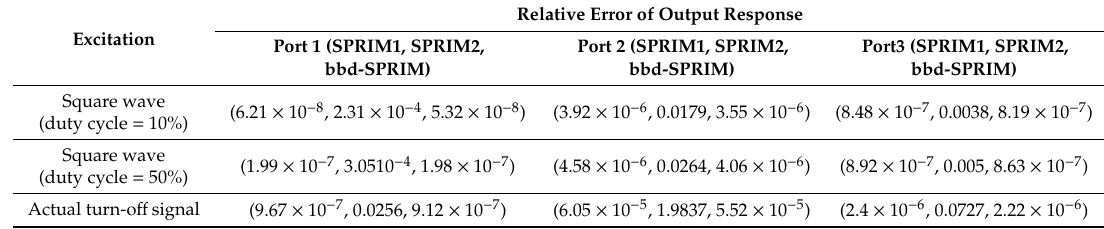
Table 2. Relative errors of the responses for SPRIM and the proposed broadband SPRIM (reduced